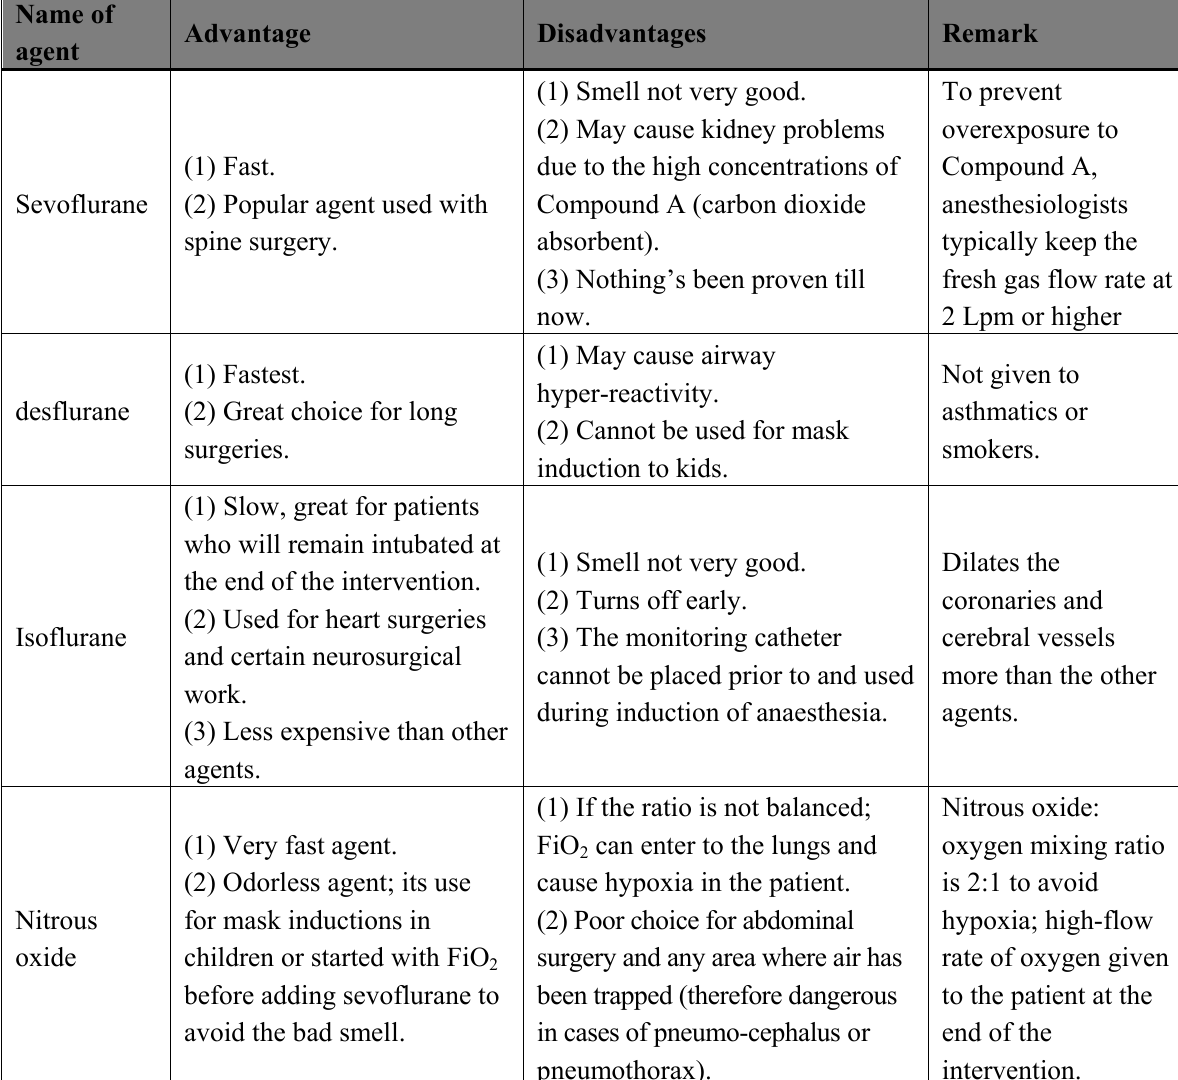
Table 2. Characteristic of the Most Common Inhalational